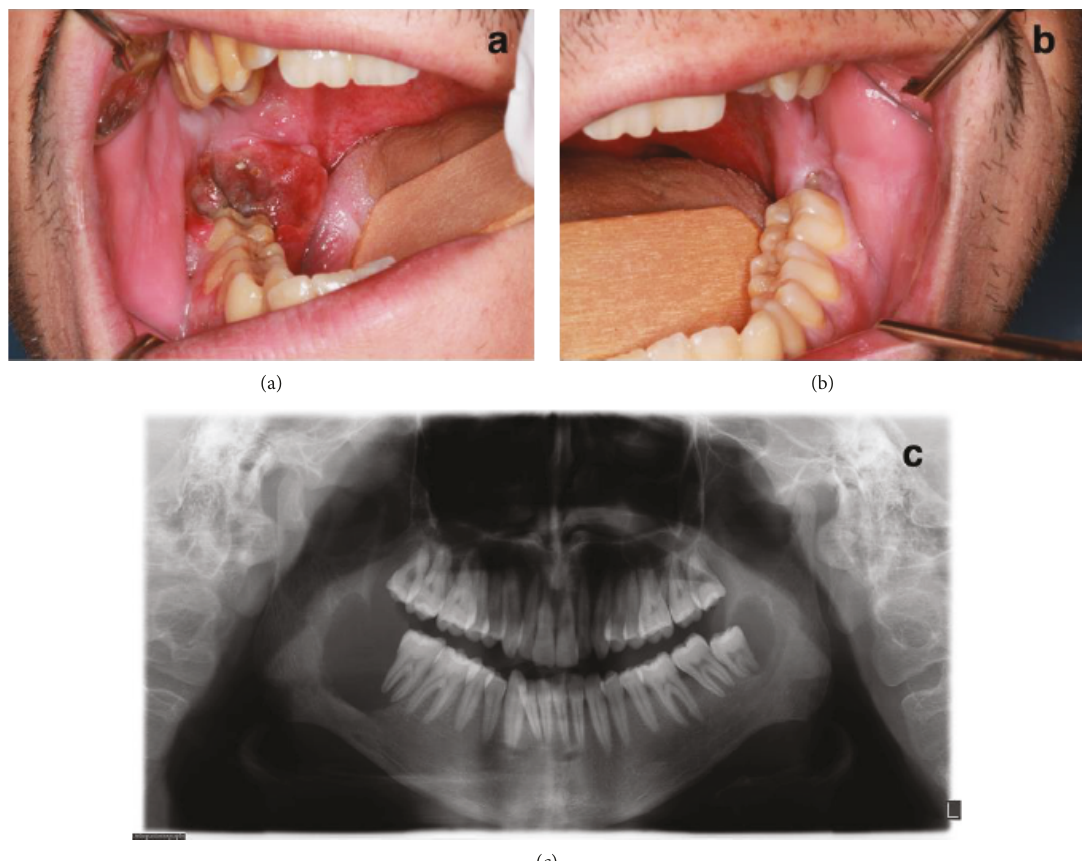
Figure 1: (a) Initial intraoral appearance of the brown tumor (right side). (b) Initial intraoral appearance of the brown tumor (left side). (c) Diagnostic panoramic radiography of bilateral brown